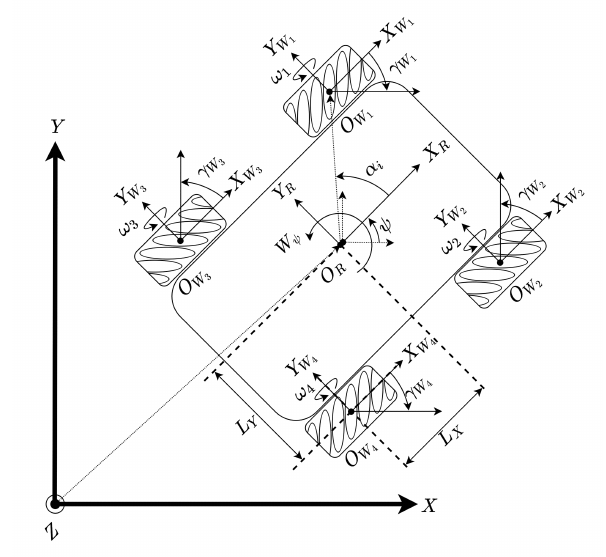
Figure 2. Kinematic